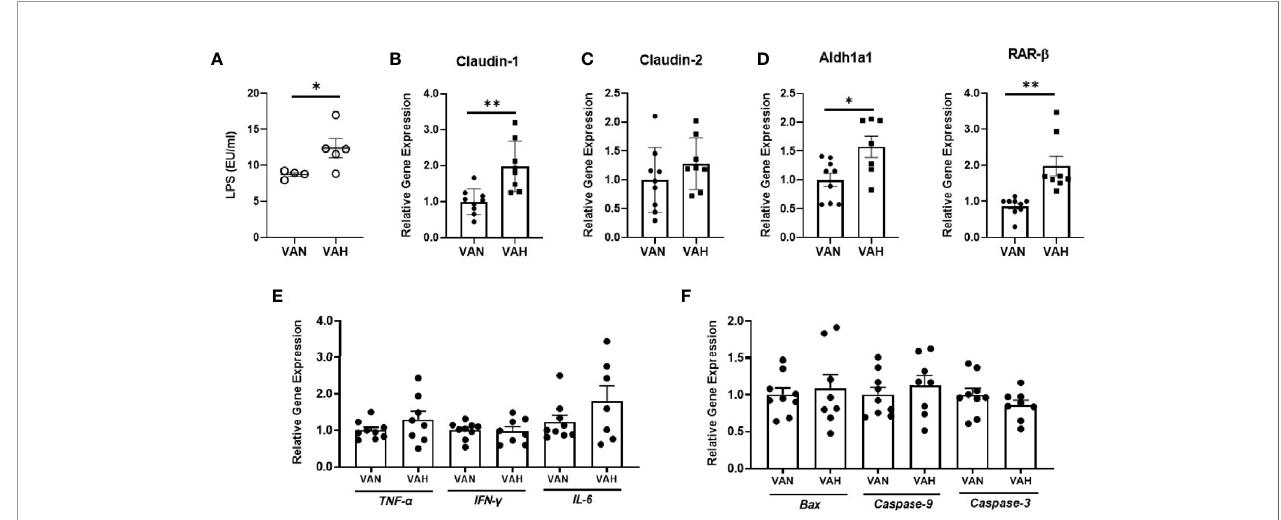
FIGURE 2 | Recipient mice fed a diet high in vitamin A show increased gut permeability after allogenic BMT. Lethally irradiated VAN and VAH mice were transplanted with BM (6 – 10 x 10 6 ) plus 0.3 – 0.4 x 10 6 puri fi ed T cells from B6 mice. On Day 7 post-BMT, serum and colonic epithelium were collected. (A) Serum LPS levels in recipient mice (n = 4 – 5 per group). Data are shown as Mean ± SEM and are derived from one of two representative experiments. (B – F) Relative gene expression of Claudin-1 , Claudin-2, aldh1a1, RAR- b , in fl ammatory cytokines, and apoptotic markers of colonic epithelial cells (n = 8 – 9 per group). Data are shown as Mean ± SEM and are cumulative results from three independent experiments. Statistics: * P ≤ .05, ** P ≤